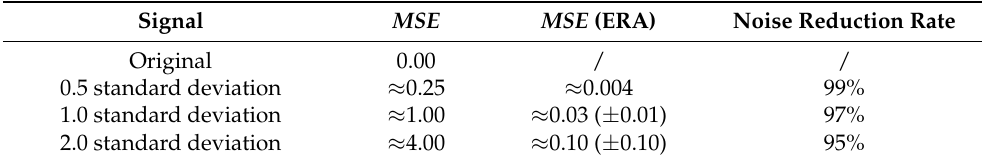
Table 1. Error statistics for different signal